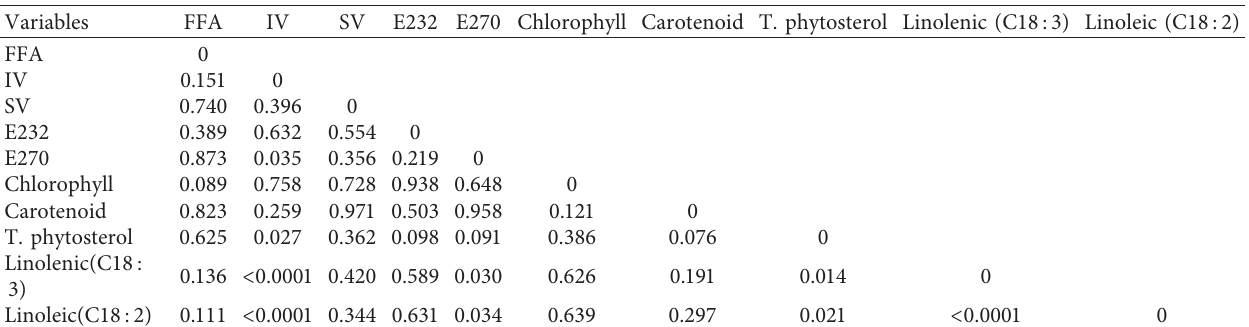
The values in bold are different from 0 at a significance level alpha � 0.05.